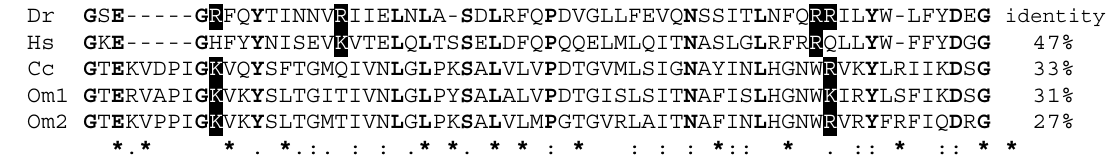
Figure 5. Alignment of the predicted lipopolysaccharide(LPS)-binding domain (LPD) of zebrafish (Dr; Danio rerio ) BPI/LDP with that of rainbow trout, LBP/BPI-1 and -2, human, and carp. Identical and similar amino acid residues are indicated by asterisks (*) and colon (:), respectively. Bars (–) indicate gaps that are introduced for optimal alignment. The number at the end of each sequence represents amino acid identities (%) to zebrafish BPI/LBD. The positive charged amino acid residues (K or R) conserved in BPI/LPD of carp (Cc; Cyprinus carpio) , rainbow trout (Om1,2; Oncorinchus mikissis ), human (Hs, Homo sapiens ) are indicated by shaded region.